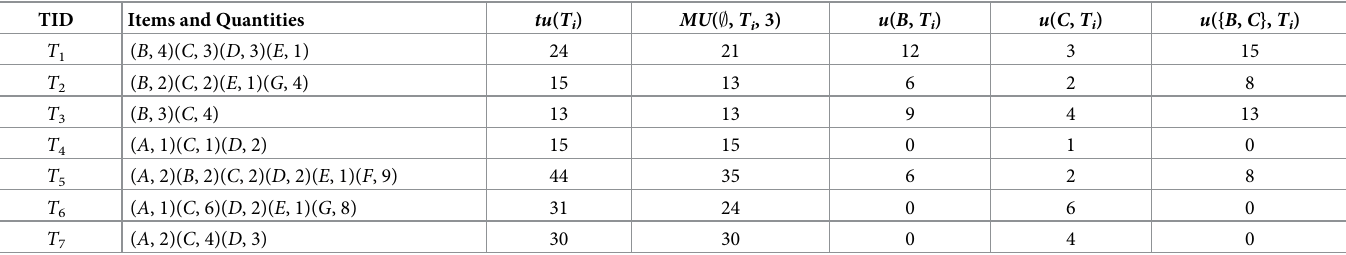
Table 1. An example database.